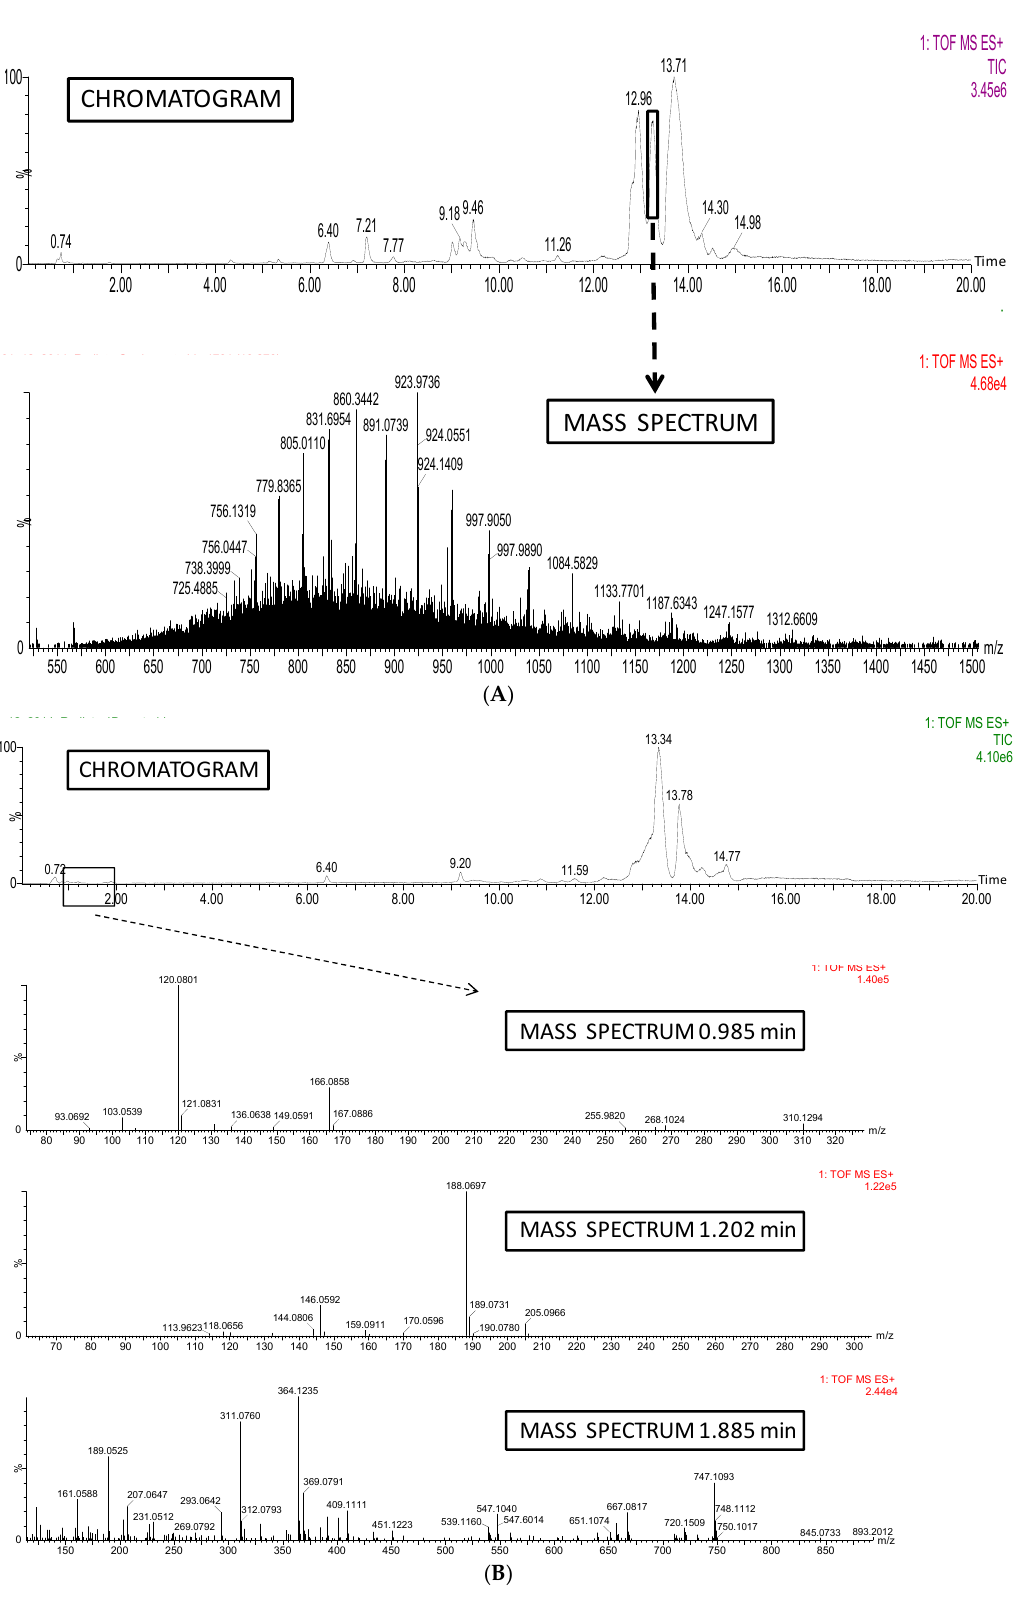
Figure 2. ( A ) Chromatogram of raw V. radiata protein and Mass Spectrum of major peak (13.270 min) of chromatogram; ( B ) Chromatogram of 4 day-germinated V. radiata protein after hydrolysis and Mass Spectrum of hydrolysis-derived peaks (0.985, 1.202, and 1.885 min, respectively) of chromatogram.